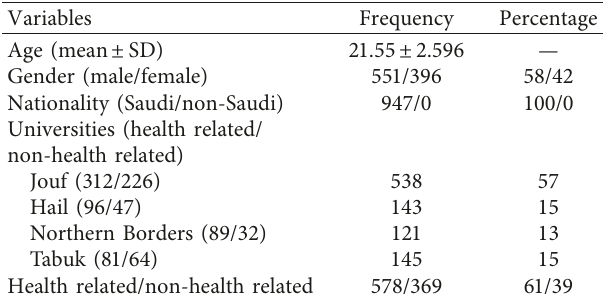
Table 1: The characteristics and demographic features of the participants.